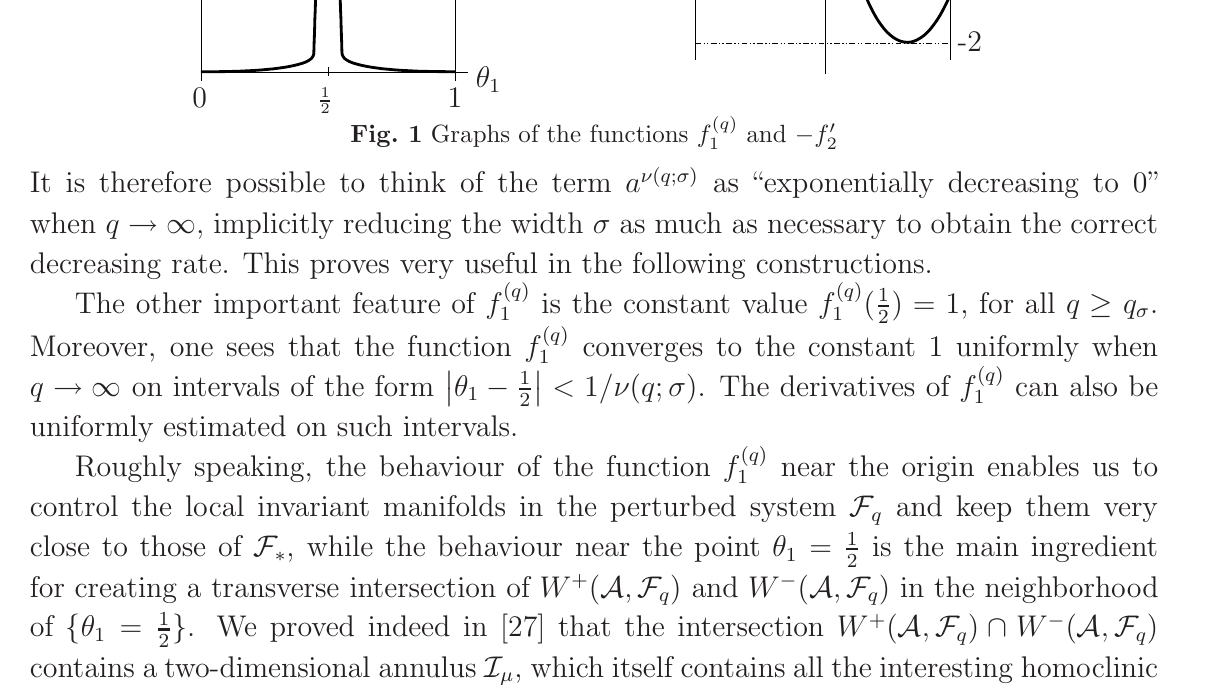
Fig. 1 Graphs of the functions f ( q )